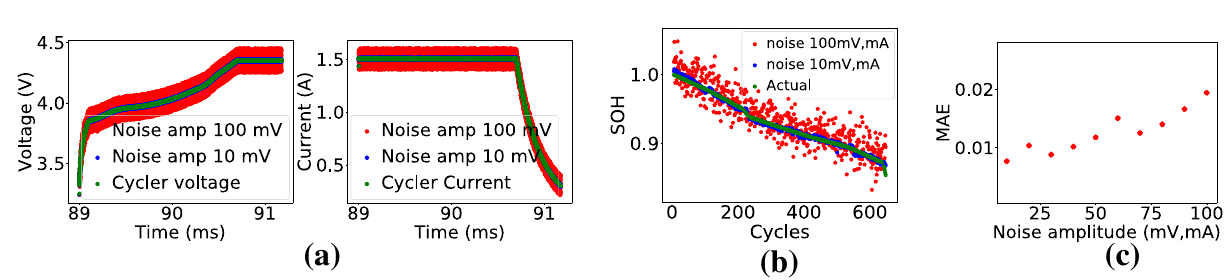
Figure 5. SOH estimation in the presence of noise. ( a ) Voltage and current with added noise, ( b ) Estimated SOH in the presence of noise, ( c ) SOH estimation MAE at different noise levels.